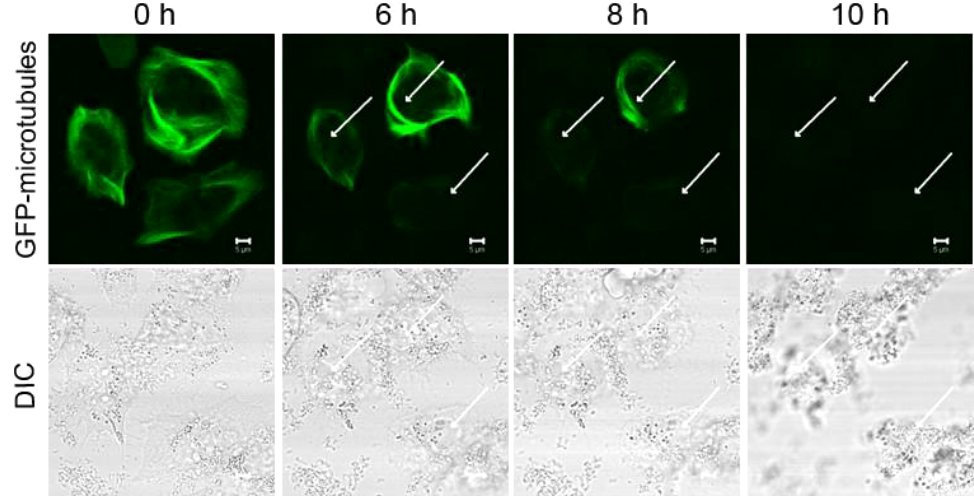
Fig. 2. Dynamical confocal imaging of living cells showing the cytoplasm vacuolization and the distribution of microtubules after taxol treatment. White arrows indicate the taxol-induced cytoplasm vacuolization. Scaled bar: 5 (cid:1) m.